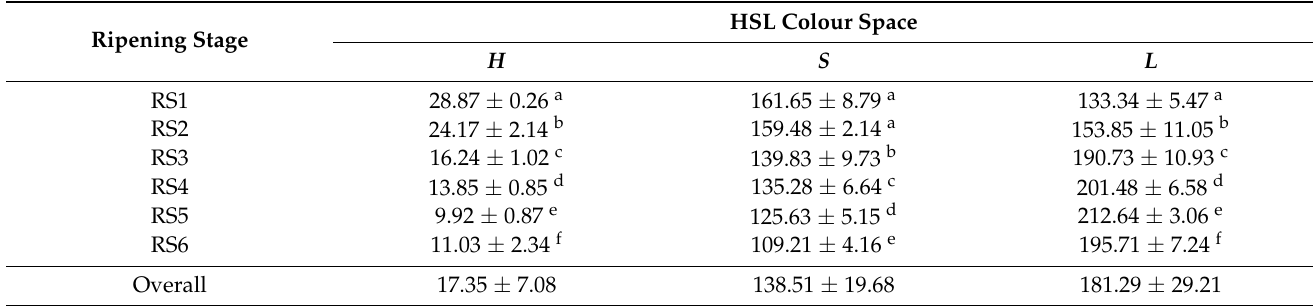
Table 4. Values of HSL (Hue: H , Saturation: S , Lightness: L ) colour space in strawberry fruits at six stages of